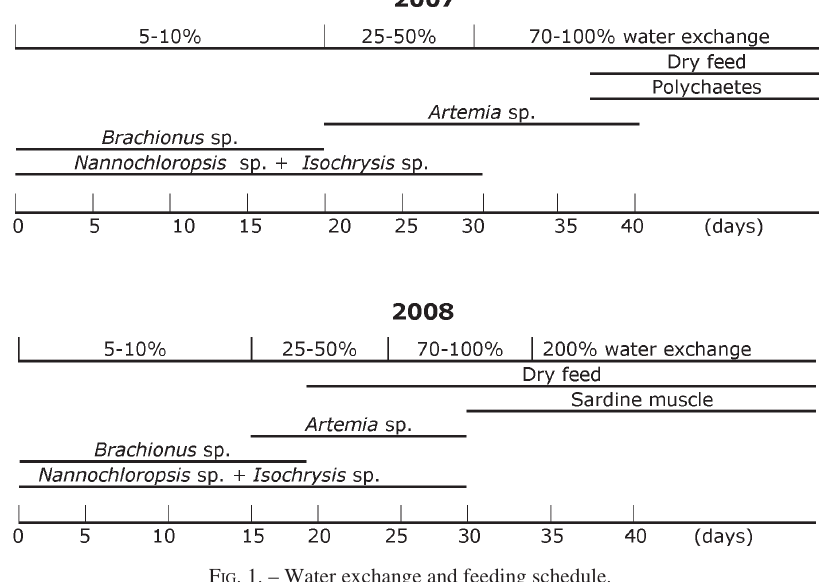
Figure 1. Water renewal was adjusted to